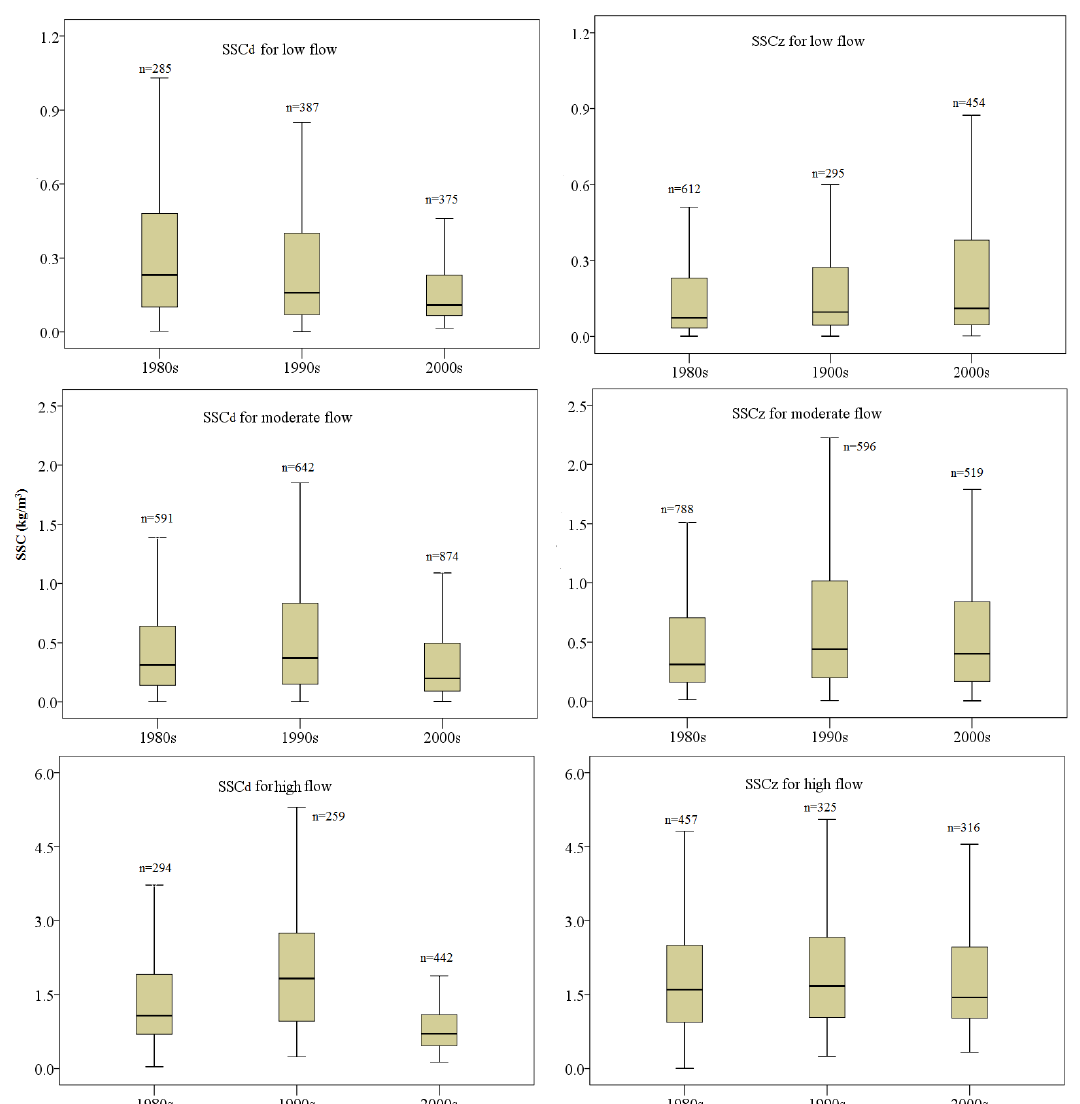
Figure 8. Box plots of